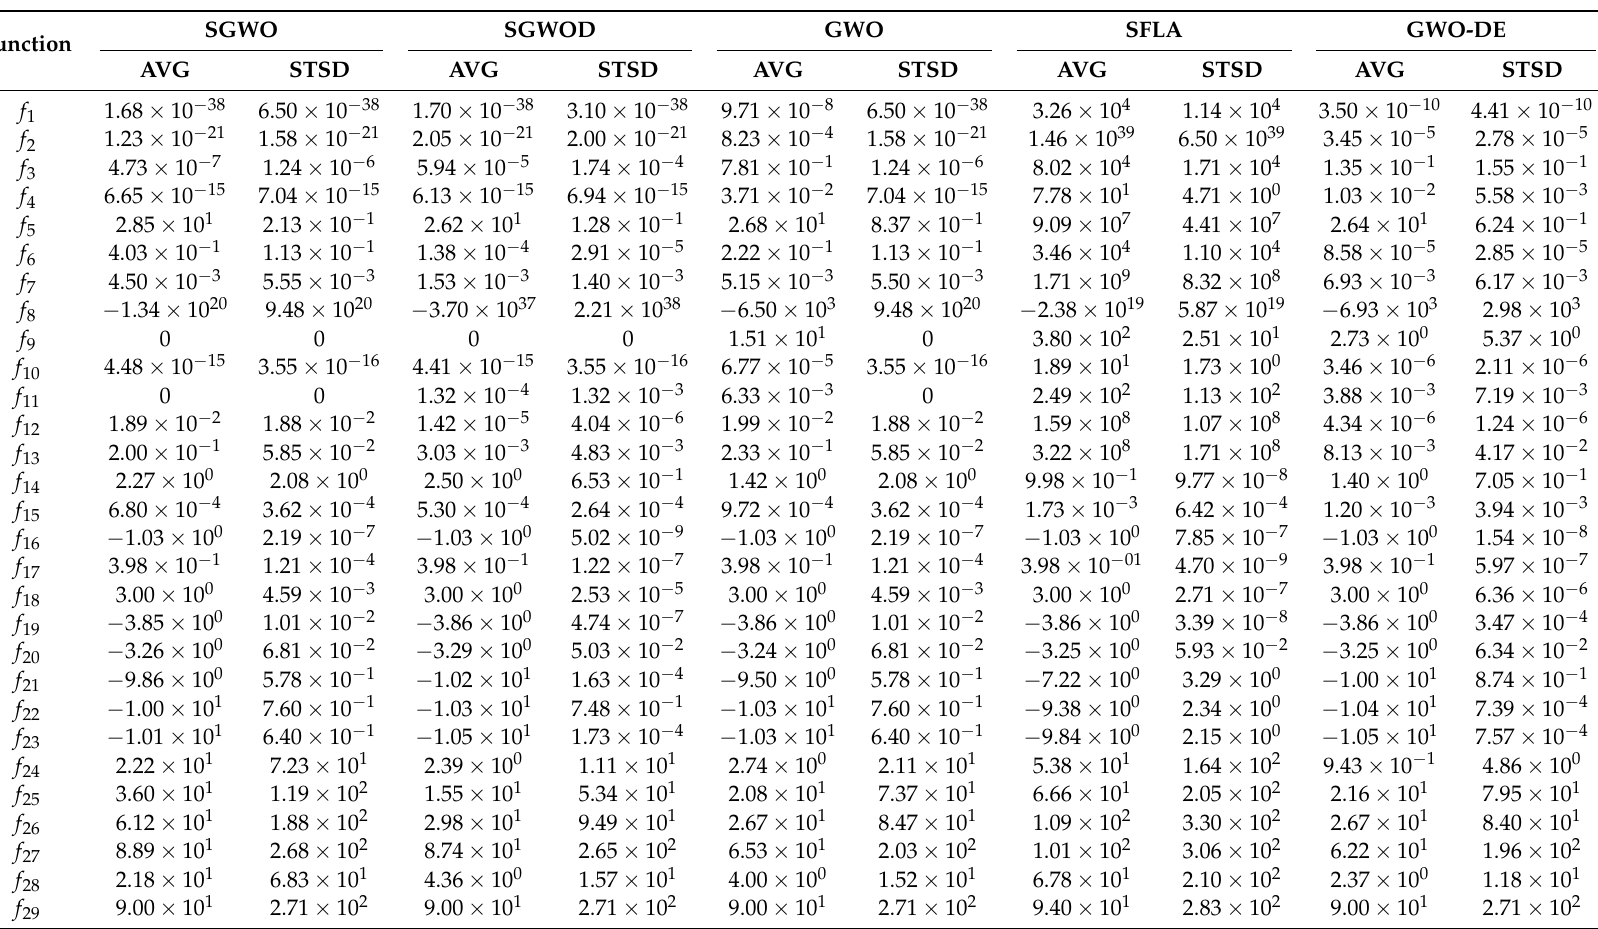
Table 6. The statistical results of the